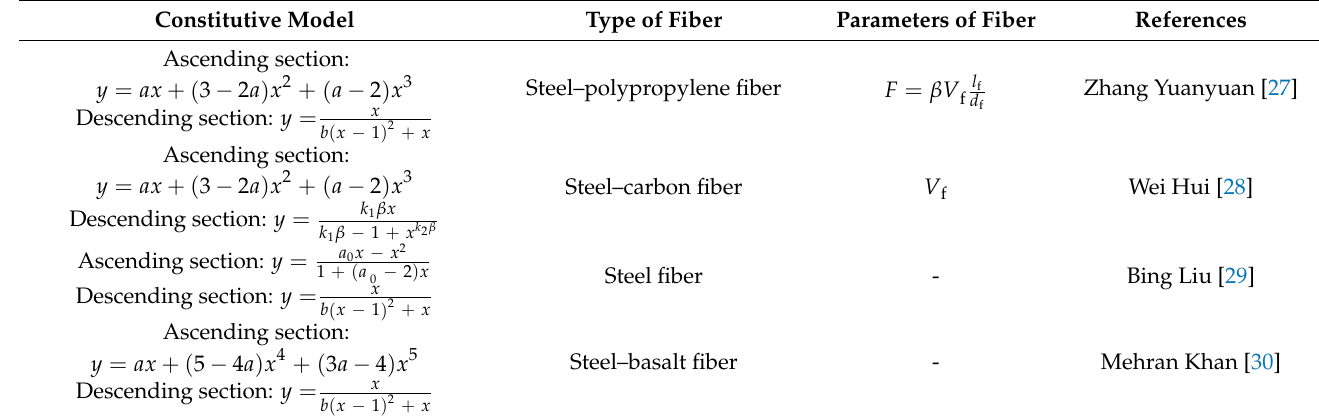
Table 6. Classical model of stress–strain curve under uniaxial compression.